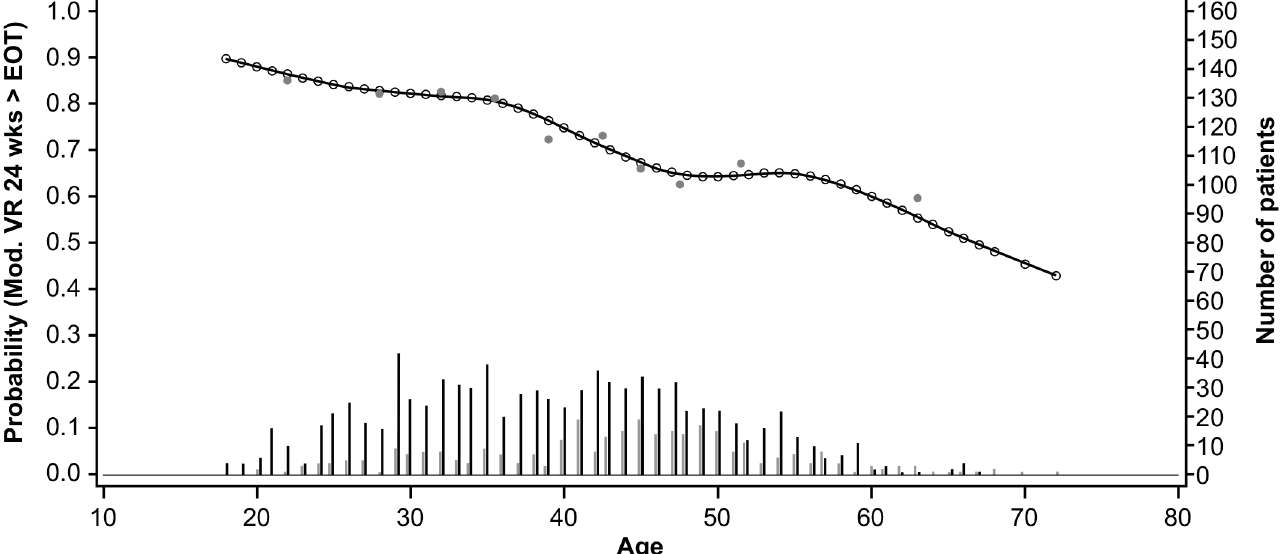
Fig 3. Relationship between age and sustained virologic response (SVR). Short vertical lines indicate the number of patients with SVR (black lines) and no SVR (grey lines). Open circles represent probability of SVR according to the GAM analysis. Closed circles represent empirical probability for midpoints of deciles. doi:10.1371/journal.pone.0150569.g003 (p < 0.0001), lower bodyweight (p = 0.0012), absence of cirrhosis (p = 0.0001), lower ALT ratio (p = 0.0203), higher platelet count (p = 0.0680) and lower HCV RNA level (p = 0.0015) (Fig 9 and S3 Table). The formula for estimating the probability of SVR based on the final logistic regression model and three examples is provided in the Supporting Information .